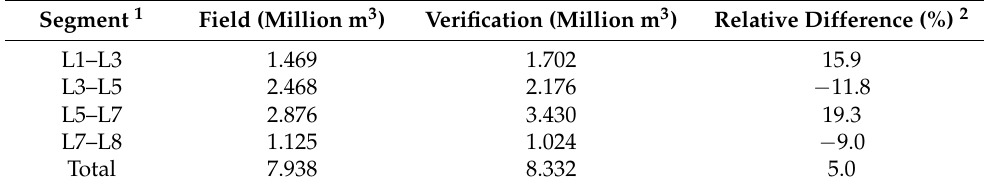
Table 2. Verification statistics of the riverbed siltation